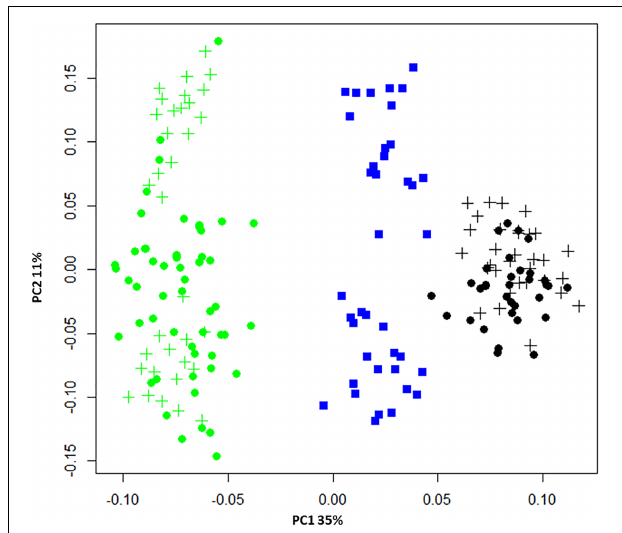
FIGURE 2 | Principal component analysis (PCA) of pairwise genetic distance. The membership of populations is indicated using blue (hybrids), green (GL), or black (BL) symbols while for the two parentage species broodstock are denoted using circles and progeny using crosses. The proportion of variance captured is given as a percentage for both the first and second principal components (PC1 and PC2).